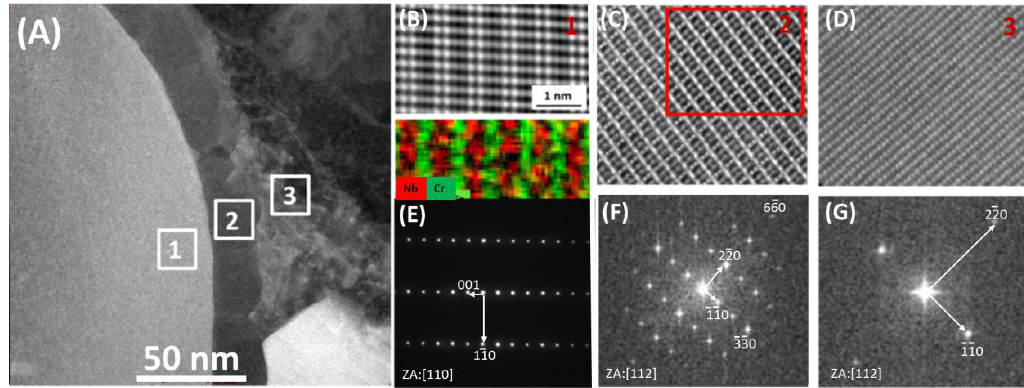
Figure 6. Area marked with red square in Figure 5A at a higher magnification: ( A ) HAADF image of Z-phase / M 23 C 6 / matrix interface, ( B ) HRSTEM image of Z-phase with EDS map (area 1 in Figure 6A), ( C ) HRSTEM image of M 23 C 6 precipitate (area 2 in Figure 6A), ( D ) HRSTEM images of matrix (area 3 in Figure 6A), ( E ) SAED from the Z-phase, ( F ) FFT showing spots from M 23 C 6 , ( G ) FFT showing spots from the matrix.